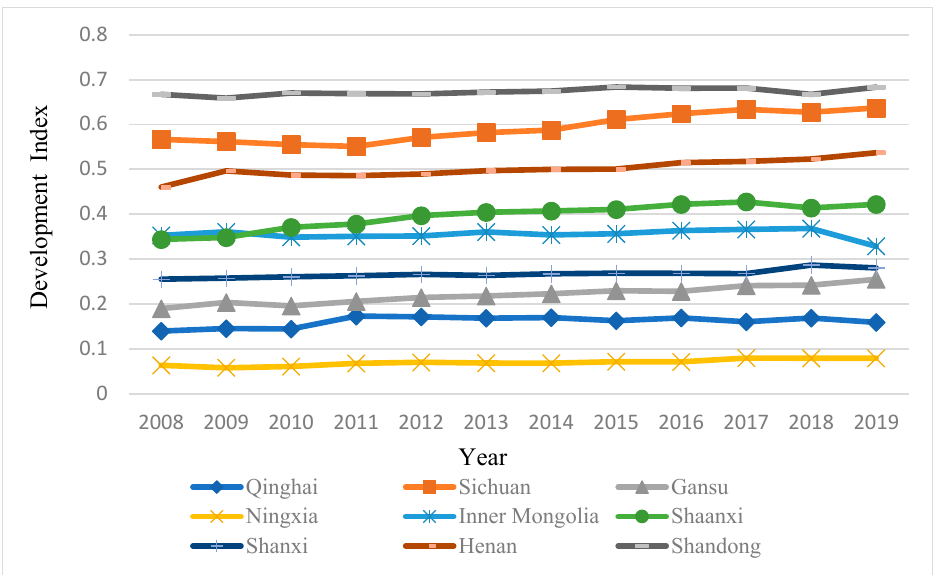
Figure 4. Comprehensive Development Status of Tourism, Ecological Environment, and public service in Nine Provinces of the Yellow River Basin from 2008 to 2019.